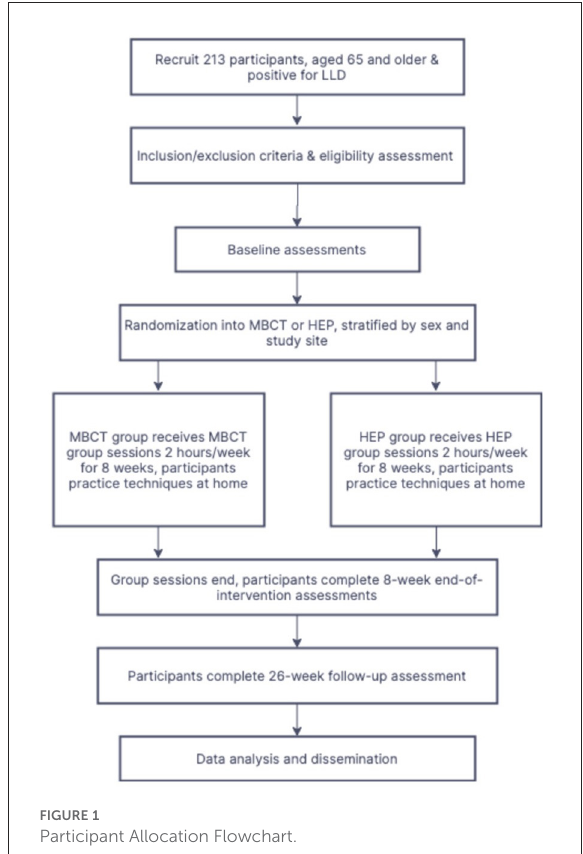
FIGURE1 Participant Allocation